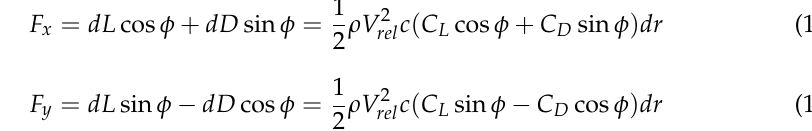
where C L and C D are the lift and drag coefficients of the sectional airfoil, respectively, which are functions related to r ; ρ is the air density; and c is the chord length of the blade element.